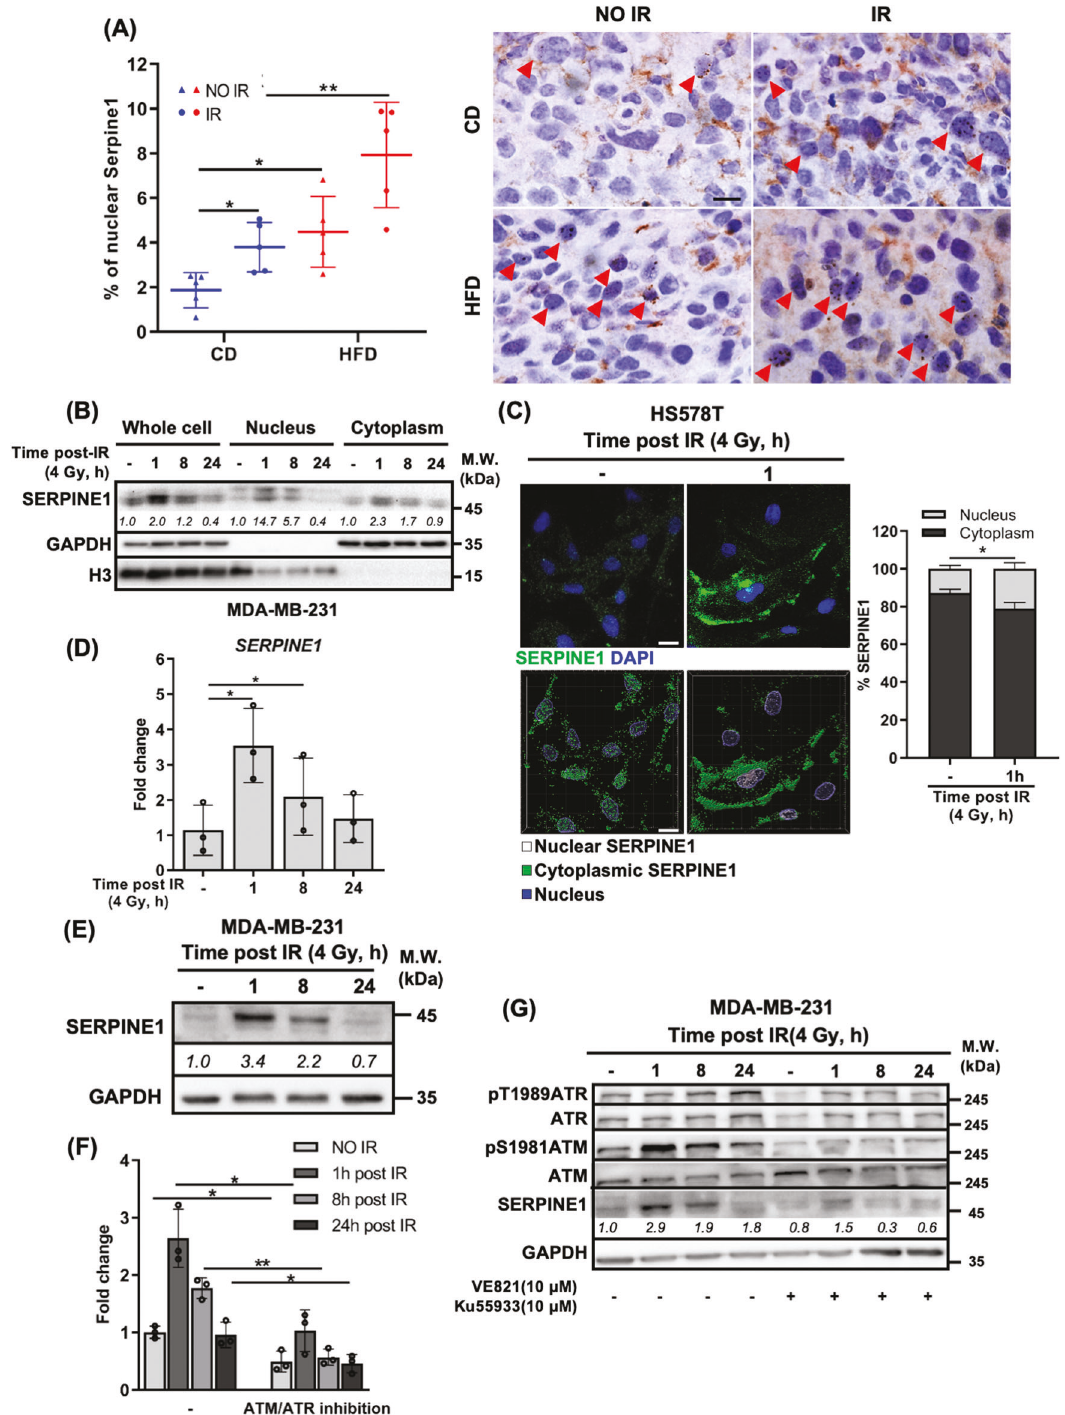
Fig. 3 IR induced the expression and nuclear localization of SERPINE1 in TNBC cells. A The nuclear Serpine1 in the tumor sections from each group of mice was detected by IHC staining. 5 fi elds from 3 tumor sections were analyzed for each group. Representative images were shown on the right panel. Scale bar: 10 μ m. B The subcellular localization of IR-induced SERPINE1 in MDA-MB-231 cells was detected by western blotting following subcellular fractionation. C Distribution of intracellular SERPINE1 in HS578T cells post-IR was detected by immuno fl uorescence staining and imaged by confocal microscopy. Approximately 20 cells were analyzed in each group per test. Representative images were shown on the left panel. 2D images were shown on the top. 3D images were shown on the bottom. Scale bar: 20 μ m. mRNA ( D ) and protein ( E ) level of SERPINE1 in MDA-MB-231 cells post-IR were evaluated by qPCR and western blotting, respectively. The kinetic of SERPINE1 induction post-IR in MDA-MB-231 cells treated with 10 μ M of ATM and ATR inhibitors were detected by ( F ) qPCR and ( G ) western blotting.